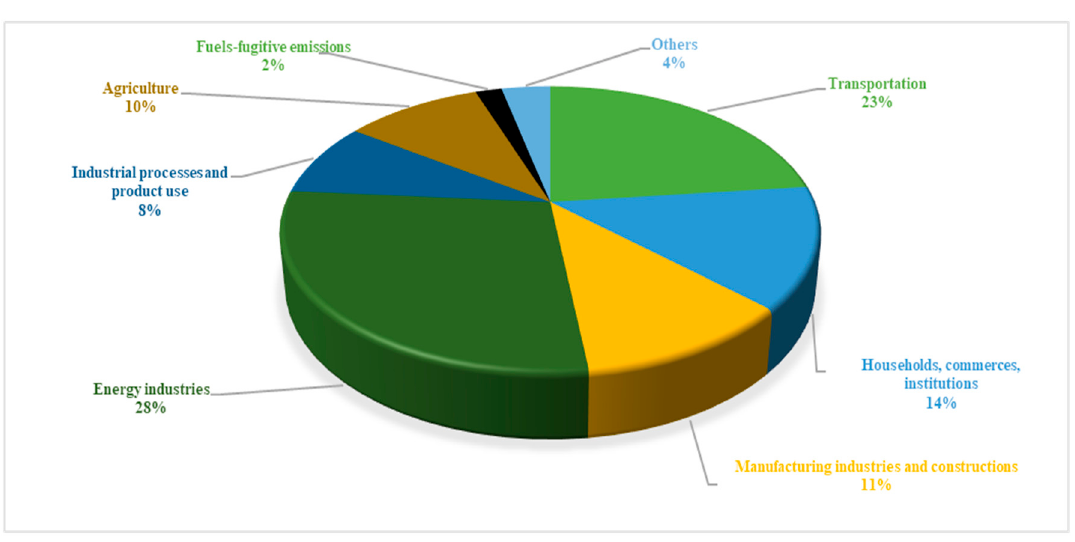
Figure 1. 2017 Greenhouse gas emissions by sector according to the Intergovernmental Panel on Climate Change [1].